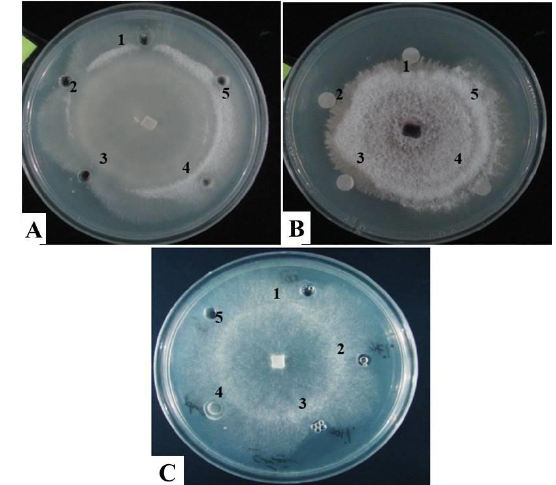
Fig. 4. In vitro antifungal assay of TFGD2 showing inhibition of the mycelial growth of different plant pathogenic fungi : (A) F. oxysporum ; (B ) V. dahlia and (C) S. sclerotiorum (1, 2 and 3= Different concentrations 5, 10 and 15 µg of purified protein respectively; 4= Protein extract of empty vector; 5= Elution